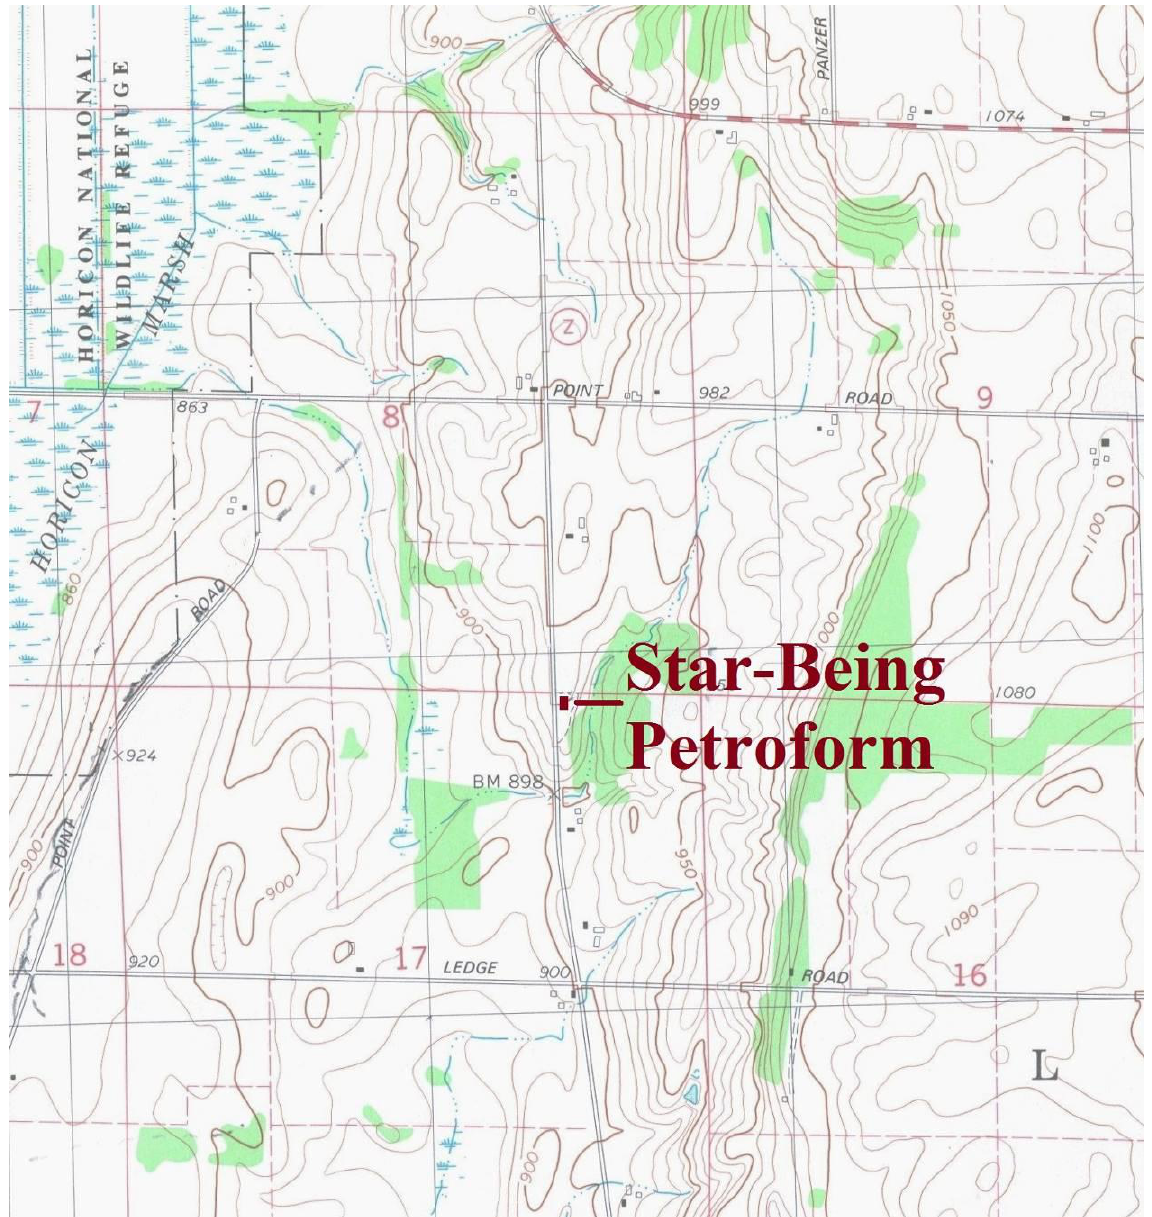
Figure 22. Portion of a United States Department of the Interior Geologic Survey, Mayville North Quadrangle, Wisconsin, 7.5 Minute Series (Topographic) map showing the location of the Star-Being petroform hill on the east side of the Horicon Marsh. Contour lines are at 10 foot